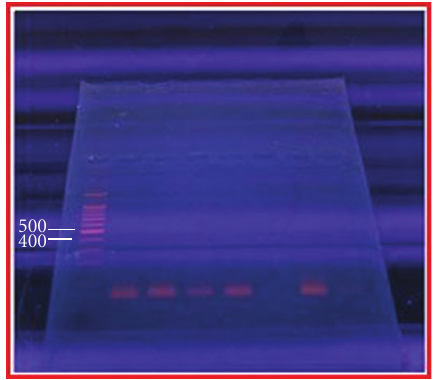
Figure 4: PCR product for H. pylori with ureA gene based primers. Lane 1, molecular ladder (1500–100) bp, no band of PCR product for H. pylori with ureA gene have been